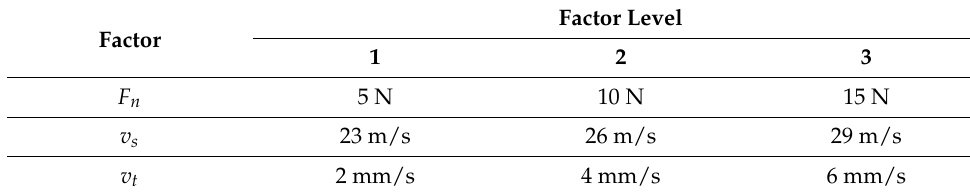
Table 2. Plan of the experiment.